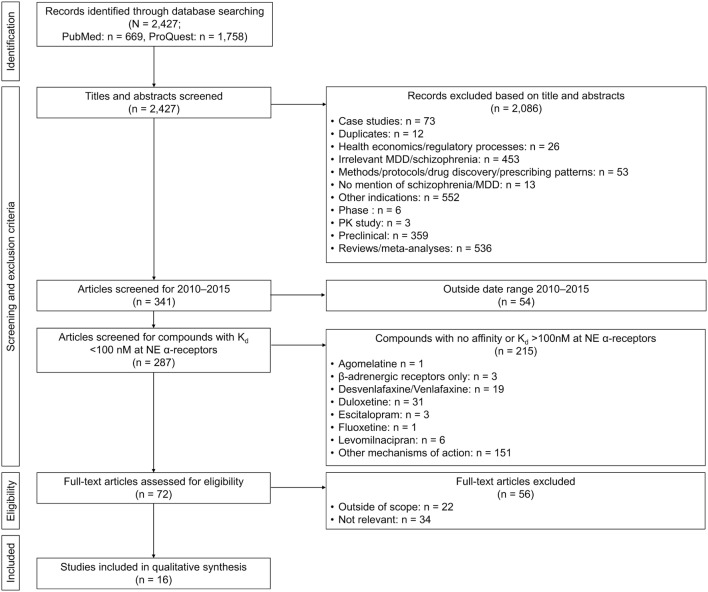
Flow diagram of article selection. MDD, major depressive disorder; NE, norepinephrine; PK, pharmacokinetics.